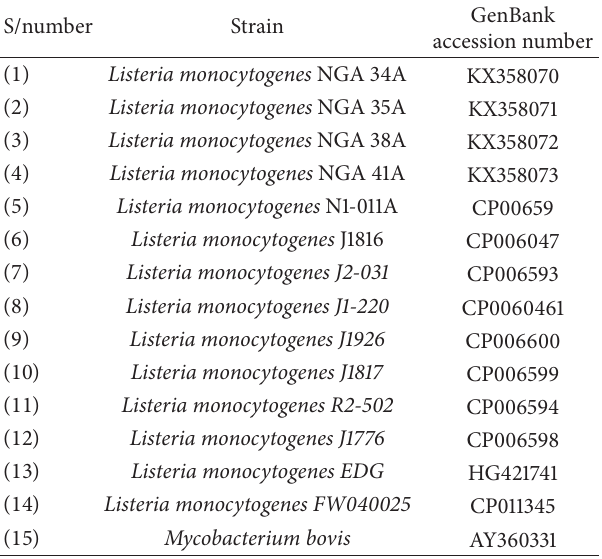
Table 3: Local and reference L. monocytogenes isolates used in the phylogenetic